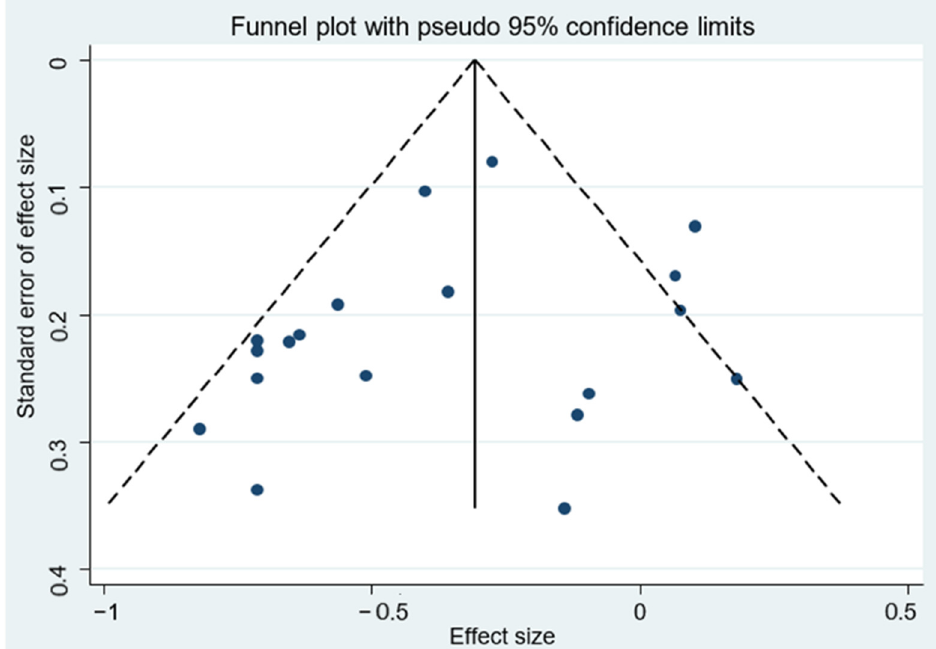
Figure 6. Funnel plot of dietary polyphenol intake and gastric cancer risk. Table 2. Subgroup analyses of dietary polyphenol intake and gastric cancer